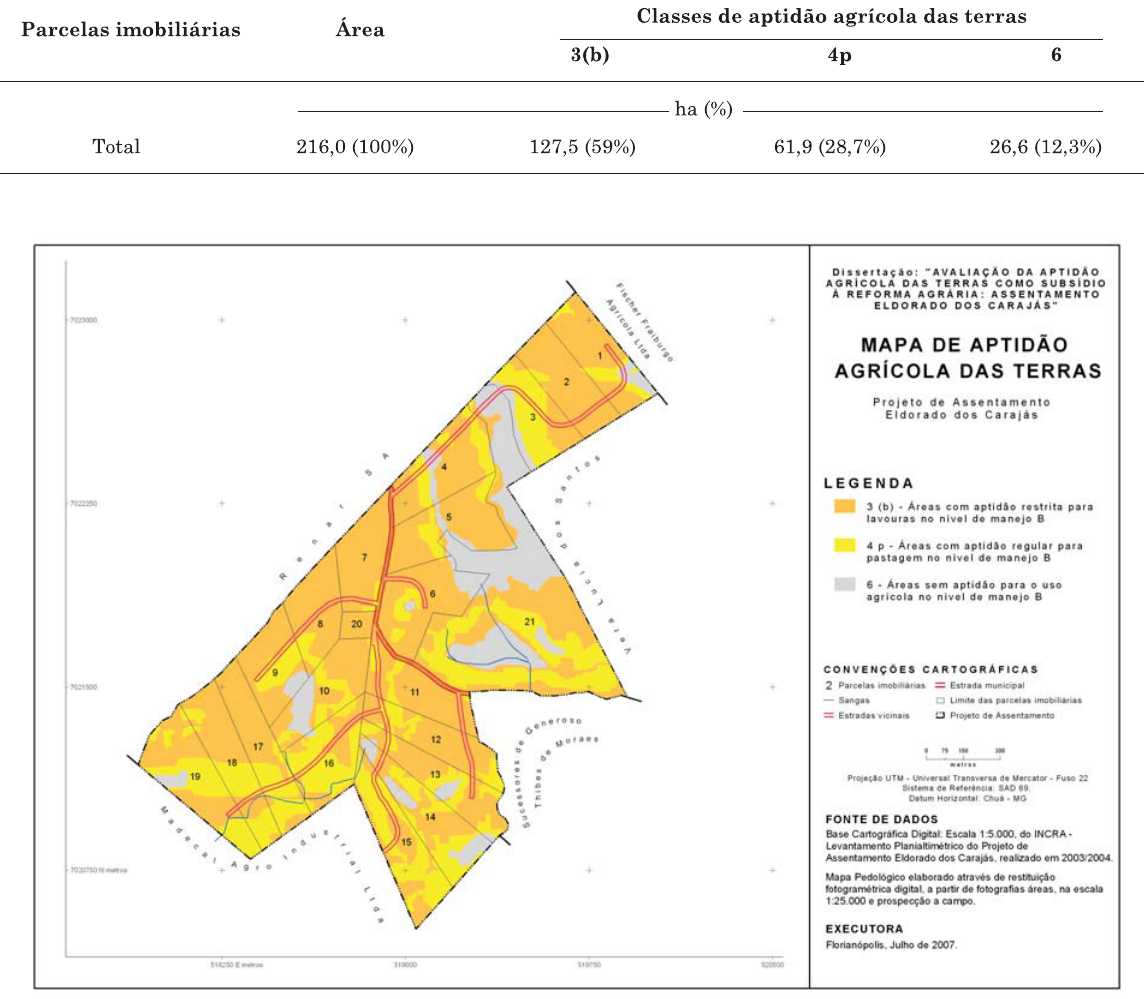
da área. No lote 21 ela ocorre em cerca de 40 % das terras (Quadro 8, em negrito). Nesta classe, as áreas